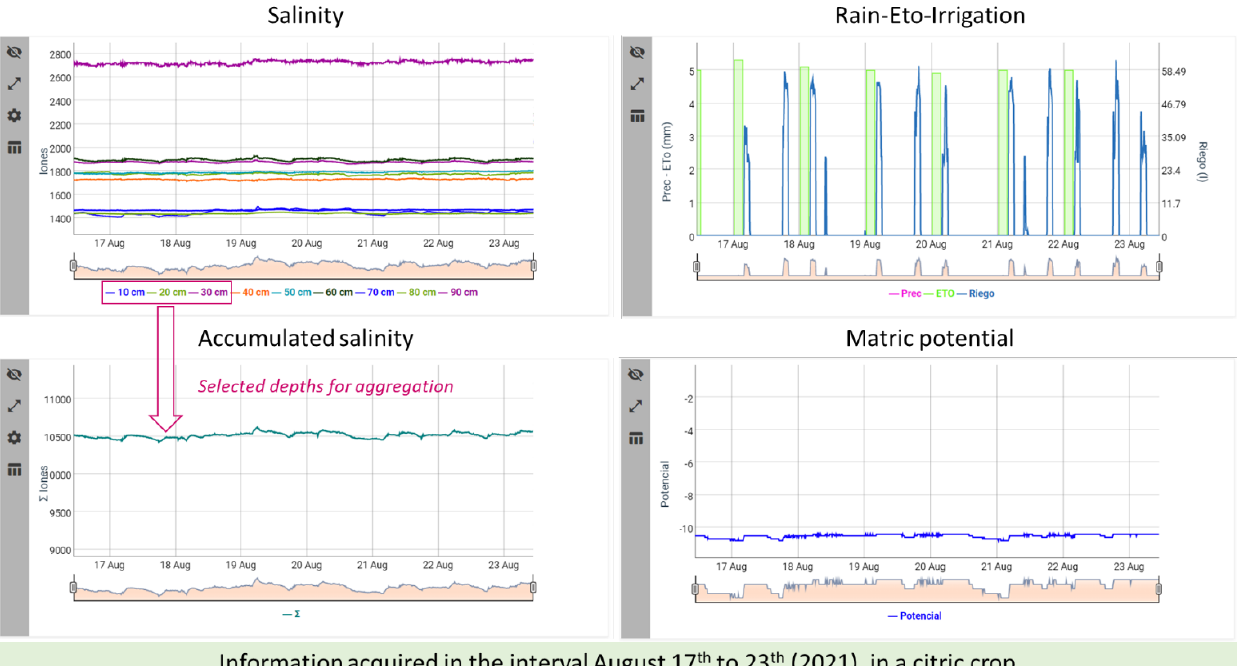
Figure 8. Charts shown when the Salinity tab is active. In this case, there exists a sensor capable of measuring matric potential, then, its time series is represented at the end of the char set. The accu- mulated salinity provides the time series resultant of value aggregation at 10, 20 and 30